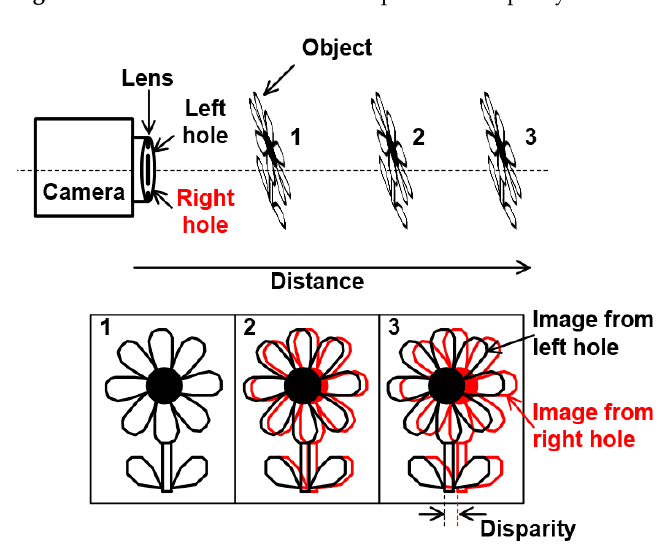
Figure 2. Disparity images from the left and right holes.